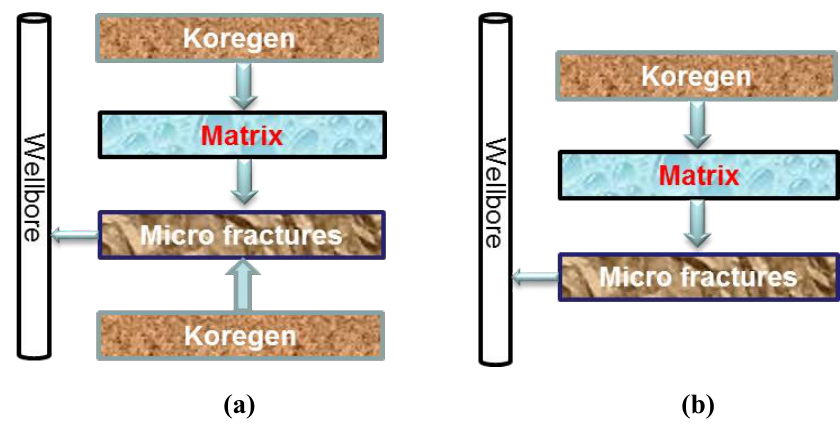
Figure 6—Schematics for shale gas flow in TPSP. (a) F-TPSP. (b) S-TPSP.